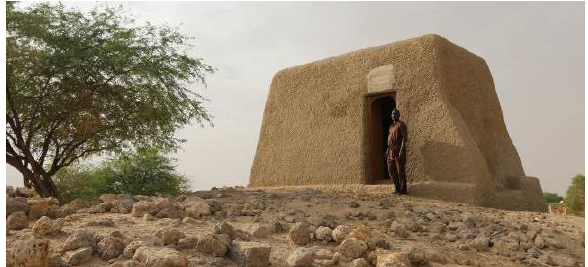
Figure 5. Mausoleums of Cheik al Tawaty (front) and Cheik Sidi Mohammed Mikki (back) after reconstruction, September 2015. © Joffroy T. CRAterre.